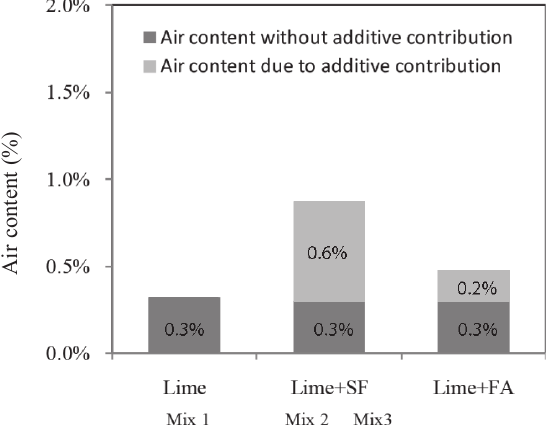
Fig. 8(a). Effect of pozzolans on air content of fresh grouts